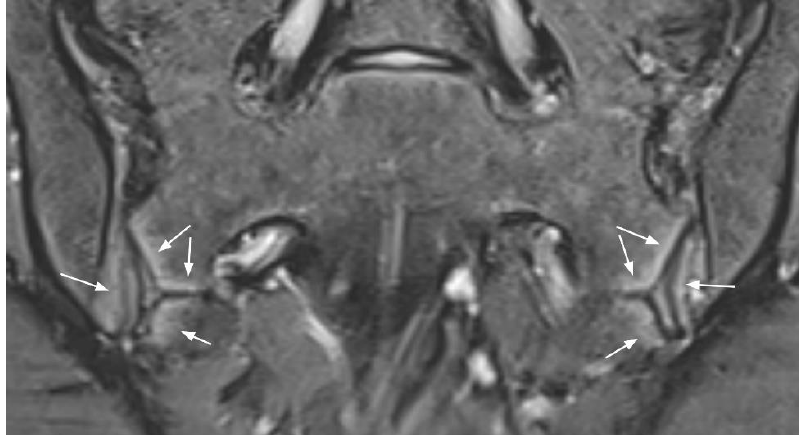
Figure 8. Normal type 2 high signal in a 15-year-old girl (coronal oblique fat-suppressed T2-weighted image). Linear band of high signal along the distal third of the SIJ that extends along partially fused sacral apophyses (arrows).